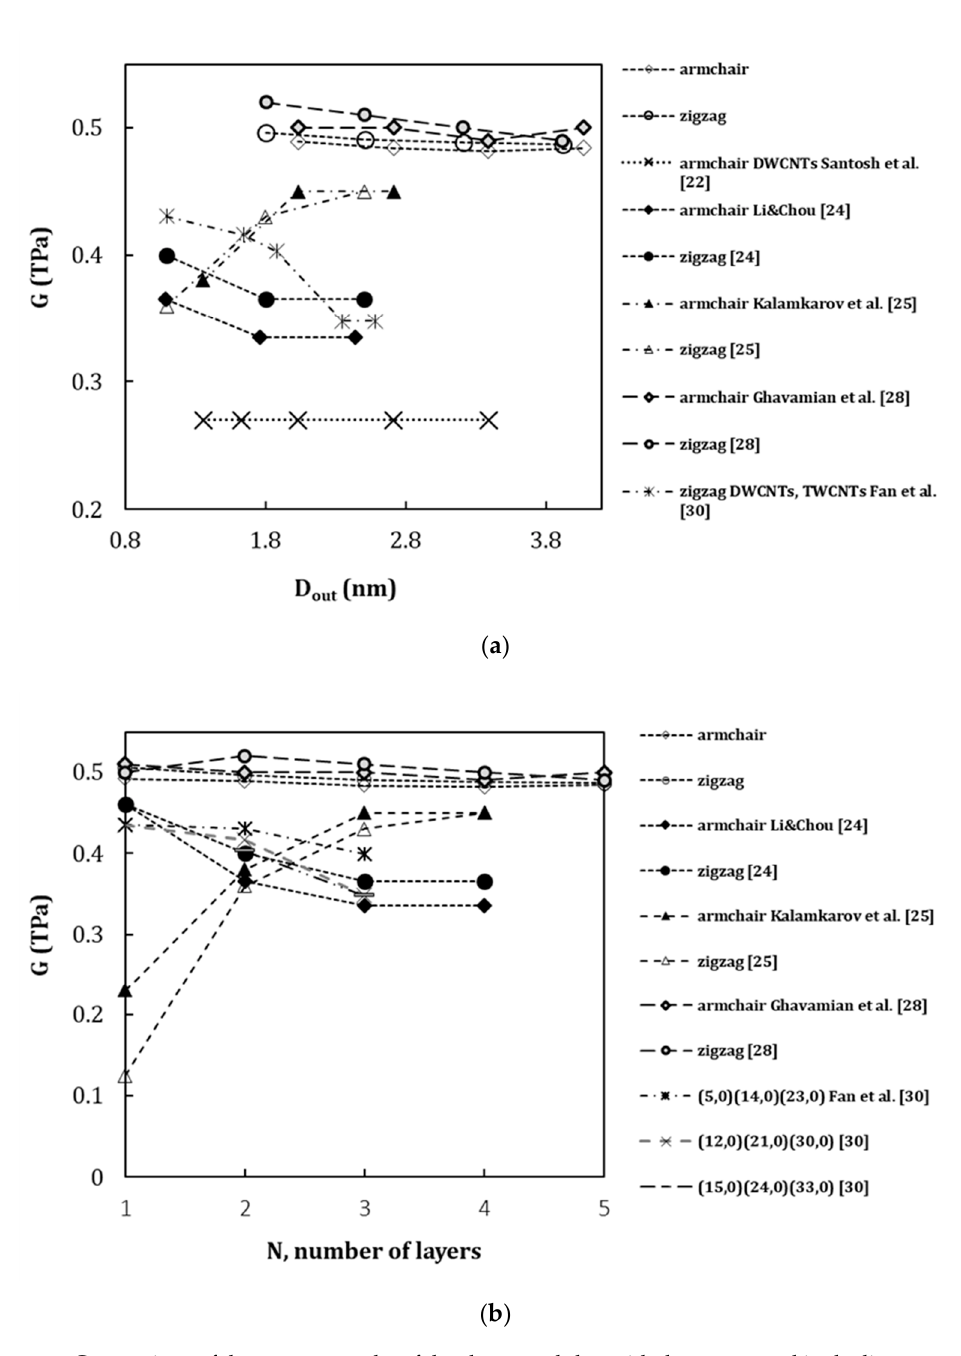
Figure 9. Comparison of the current results of the shear modulus with those reported in the literature as a function of: ( a ) outer layer diameter, D out , and ( b ) the number of layers, N , of the constituting MWCNT.